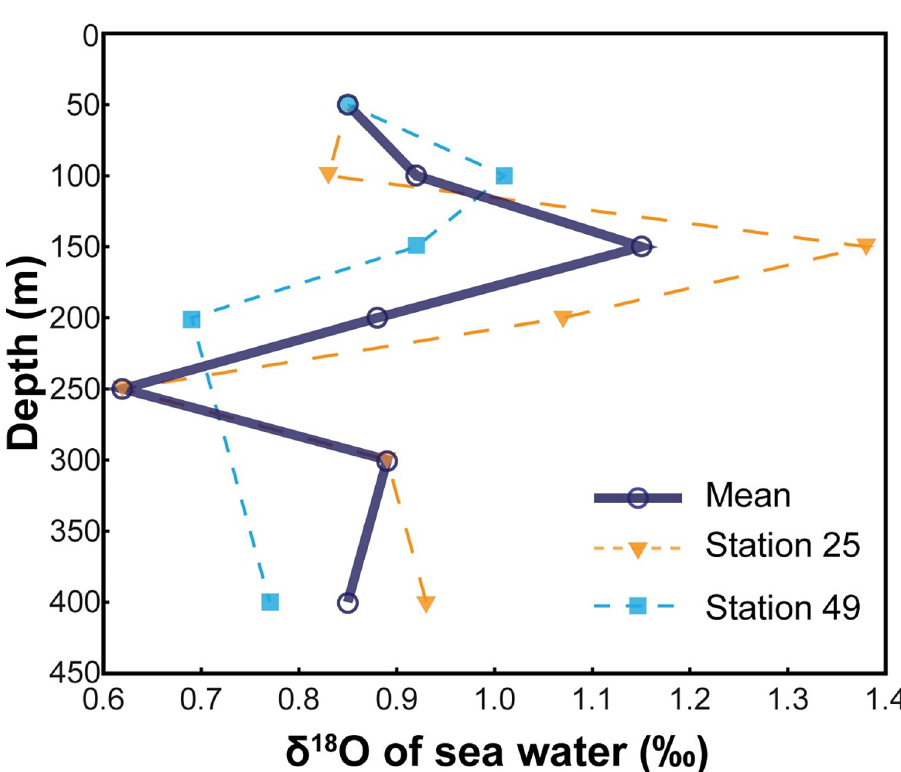
Fig 4. Isotope hydrography. Oxygen isotope composition ( δ 18 O water ; ‰ SMOW) versus depth.